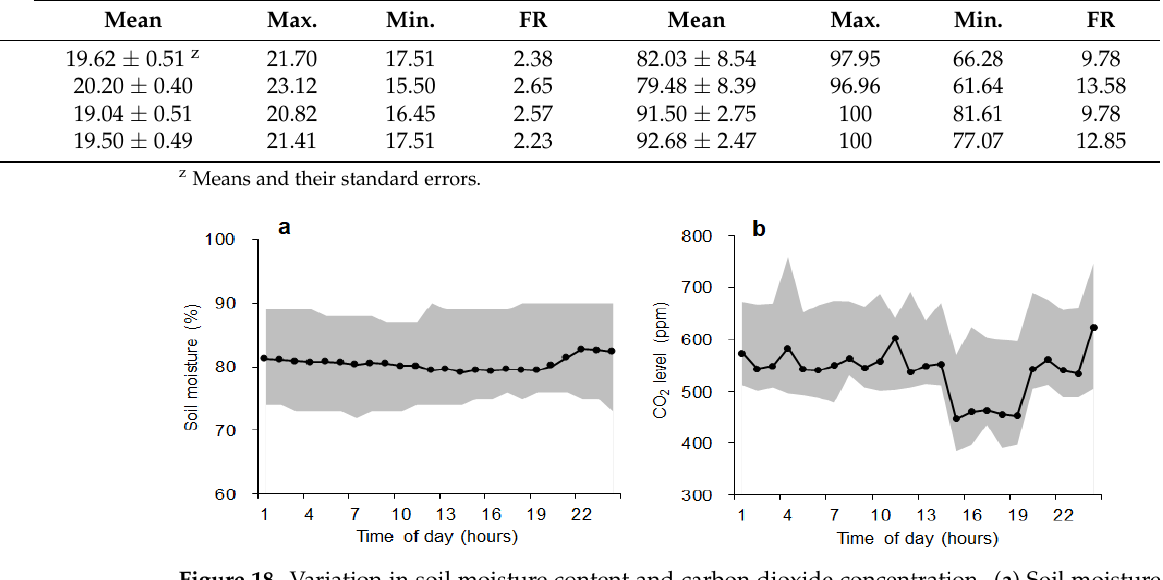
Figure 18. Variation in soil moisture content and carbon dioxide concentration. ( a ) Soil moisture content, ( b ) carbon dioxide concentration.